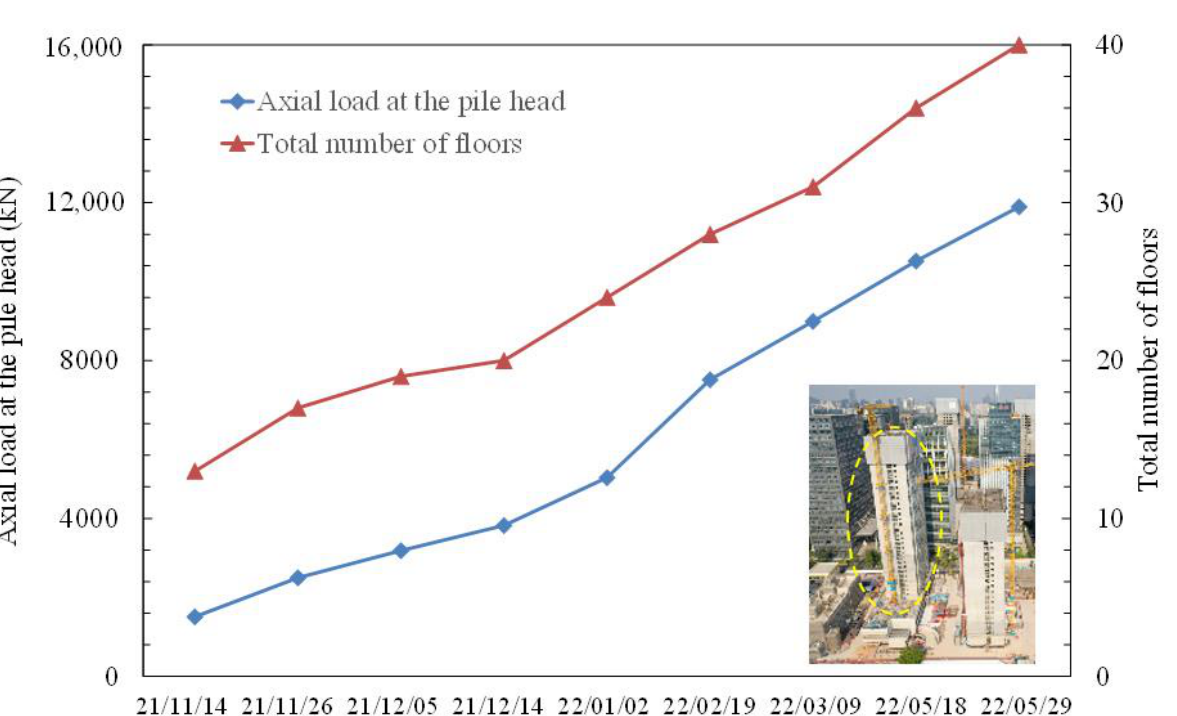
Figure 15. Variation in the axial load at the pile head with the total number of built floors.